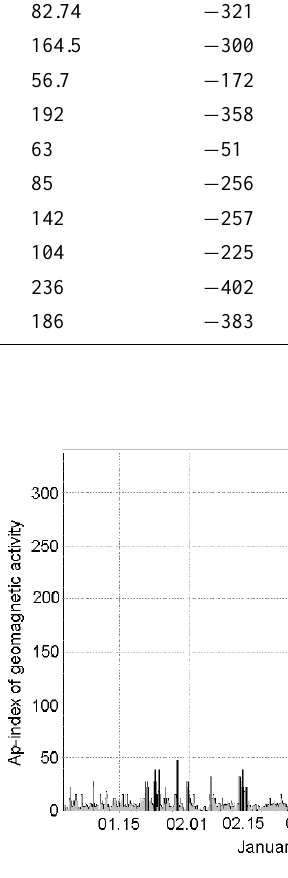
Fig. 2. Geomagnetic situation between January-April 2001 during the mission on the “MIR” landing.